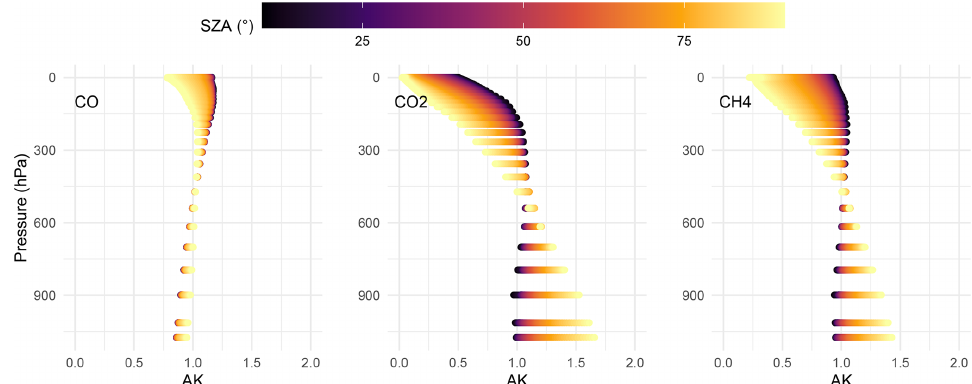
, and X CH colored by solar zenith angle (SZA). 2 4